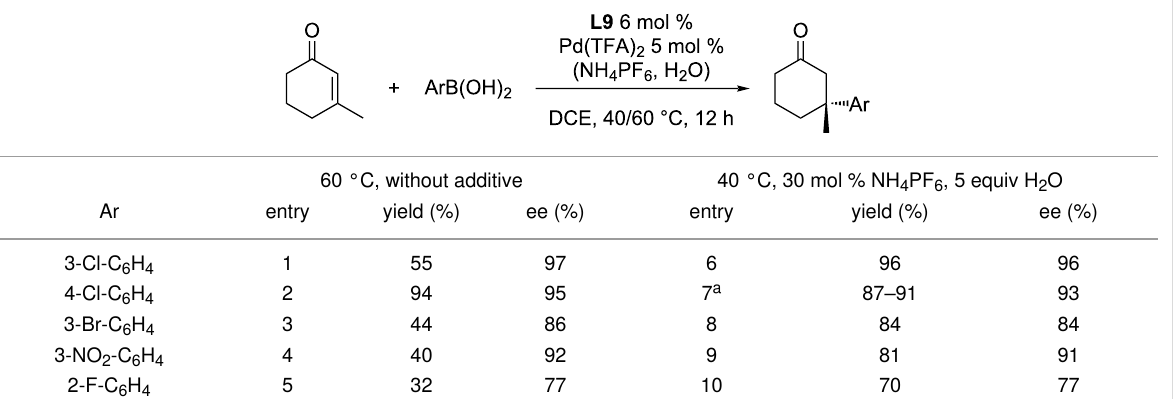
60 °C, without additive